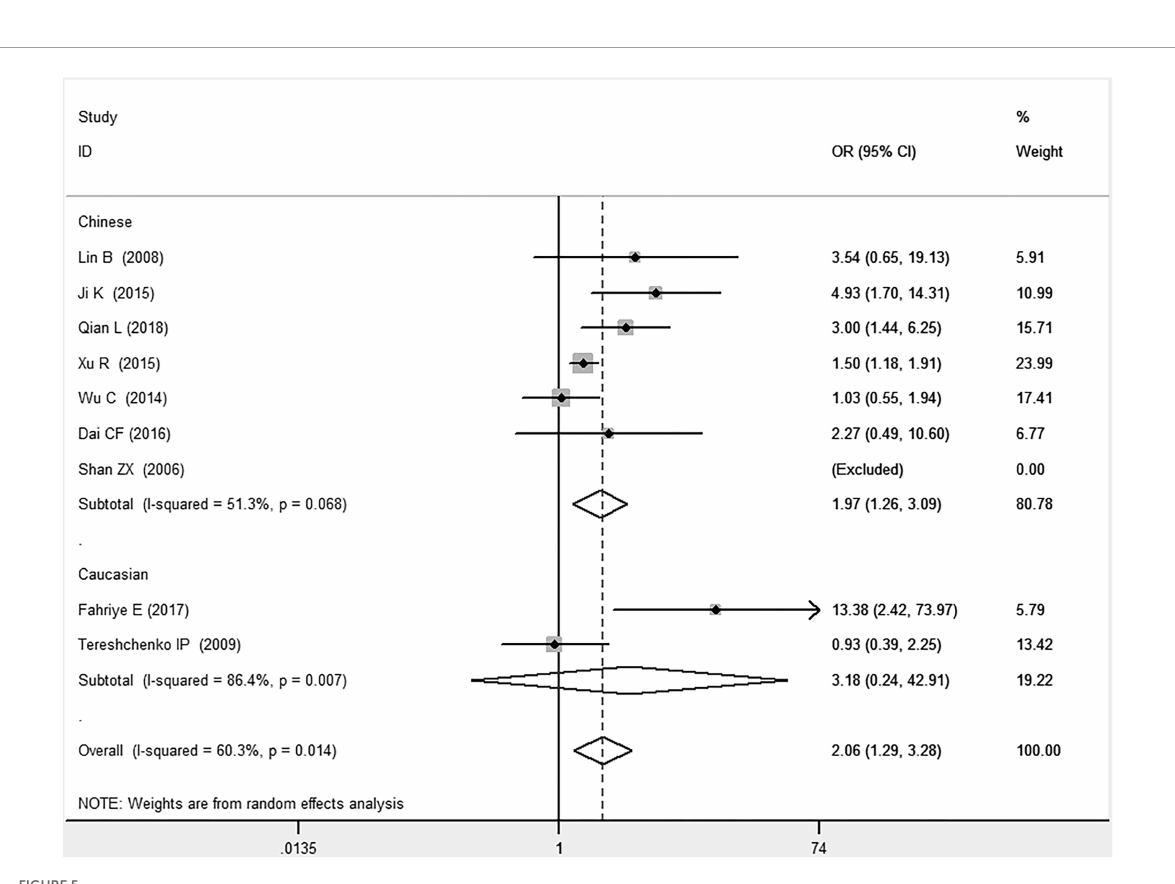
development of CAD under allelic (OR: 1.213), recessive (OR: 1.945), dominant (OR: 0.781), homozygous (OR: 2.057),